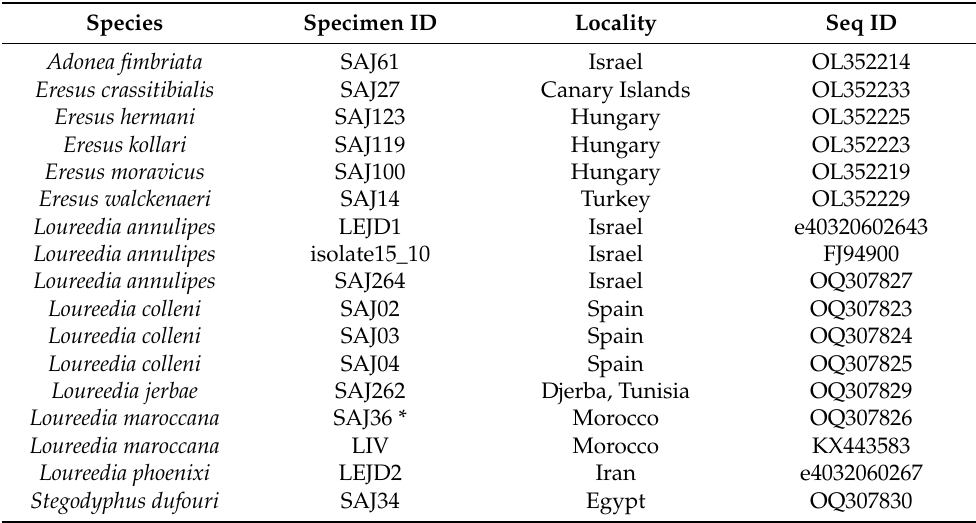
Table 1. Voucher data and sequence